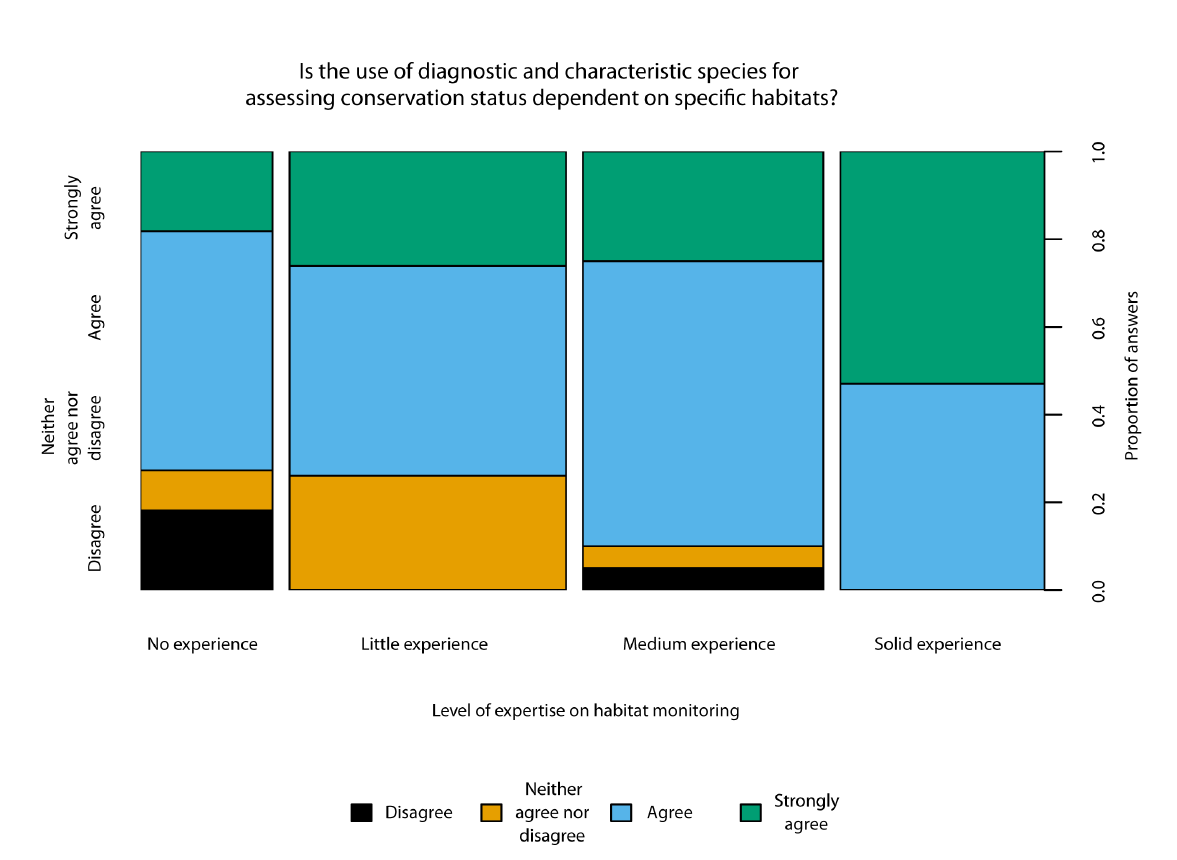
Figure 2. Spine bar plot of the ordered association between Q5, shown on y axis, and the level of experience of the surveyees. The widths of the bars correspond to the relative frequencies of surveyees for each level of